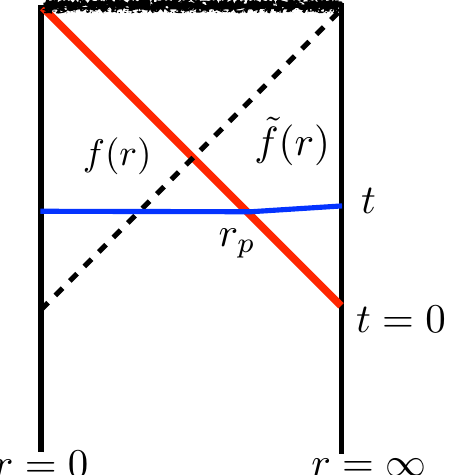
Figure 2 . AdS black hole formed by a collapsing